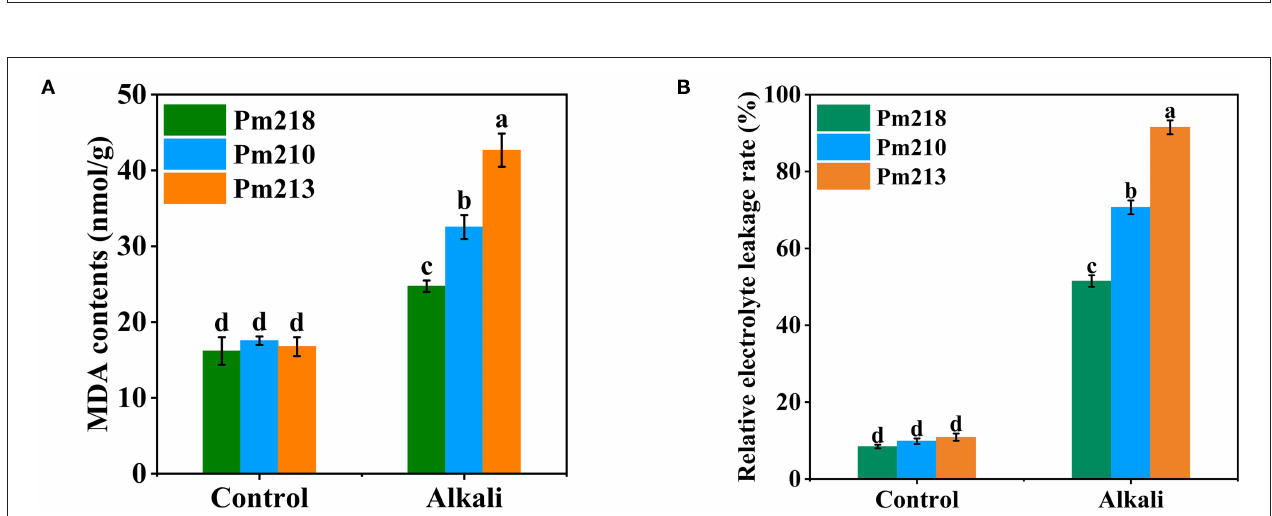
FIGURE 7 | MDA contents and RELR of three genotypes s under control (CK) and alkali stress at seedling. RELR, relative electrolyte leakage rates. (A) MDA content. (B) Relative electrolyte leakage rate. Different letters indicate significant differences ( P < 0.05).